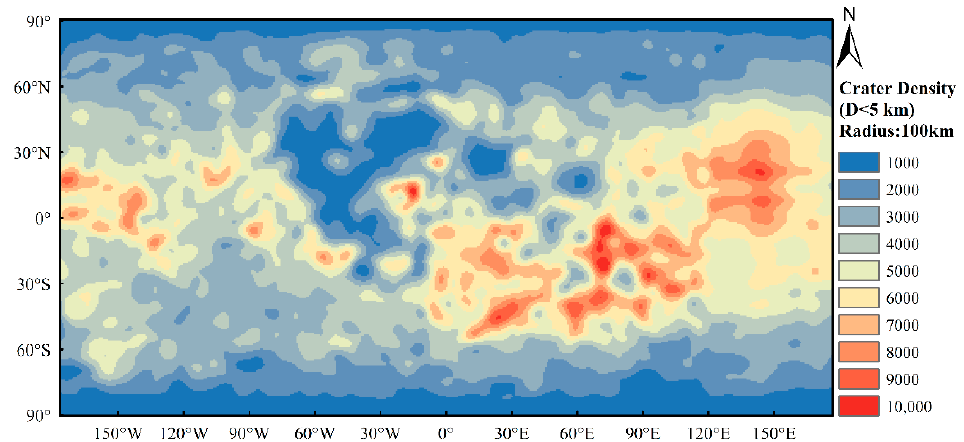
Figure 15. The density map of lunar impact craters (D < 5 km).